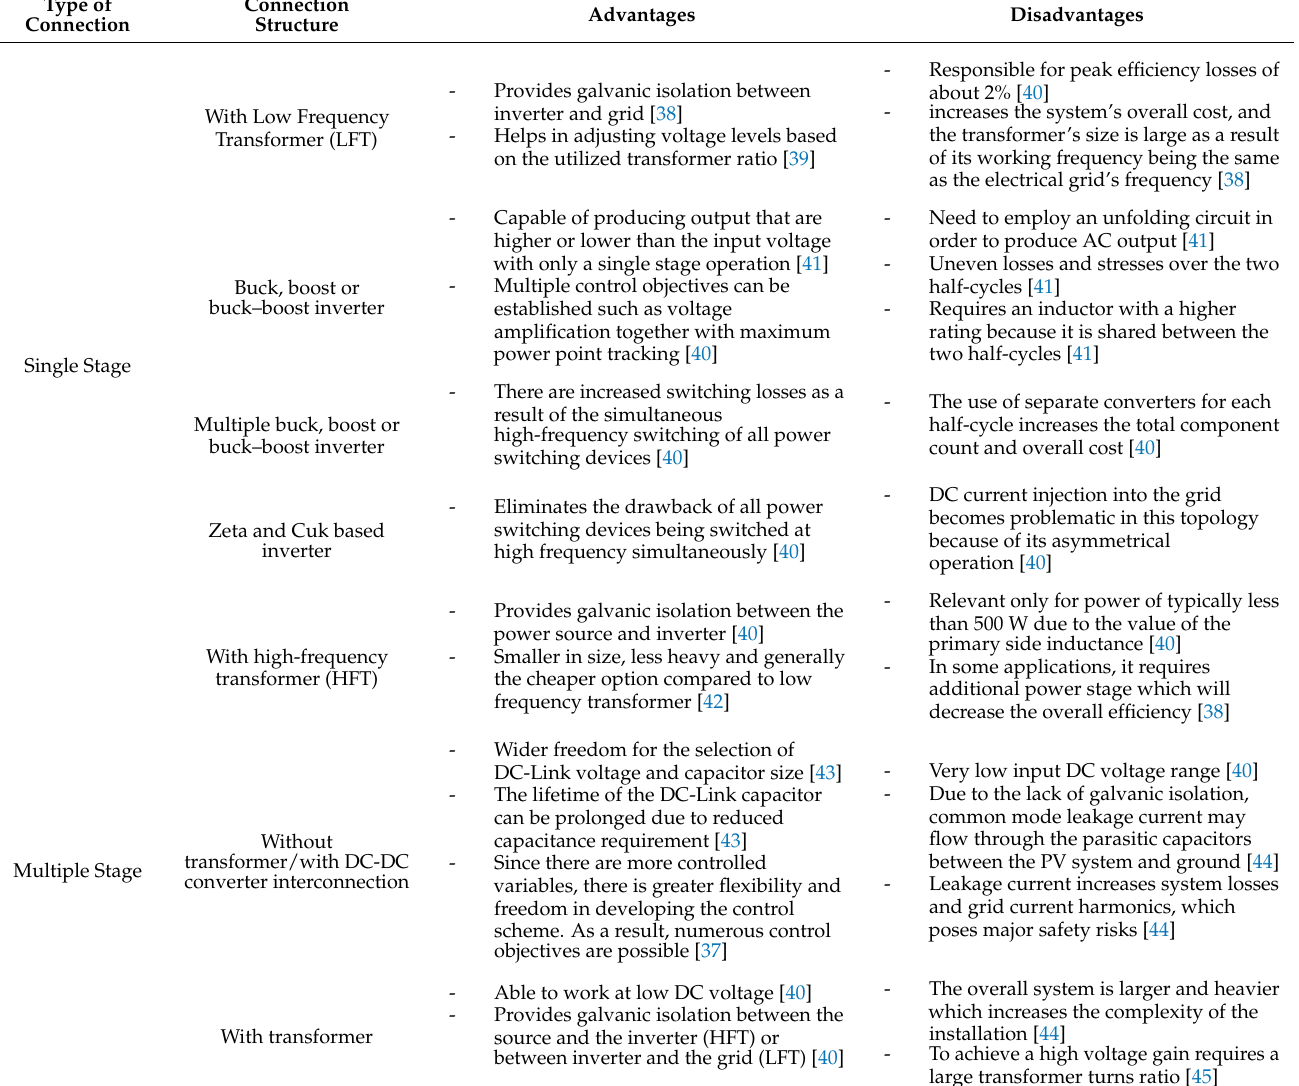
Table 2. Advantages and disadvantages of single and multi-stage